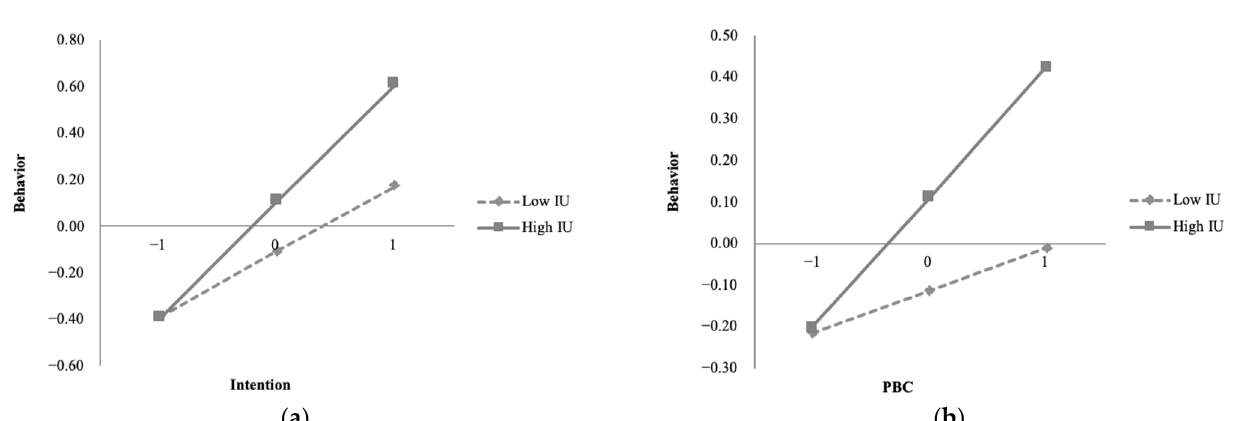
Figure 3. Moderation Analysis ( a ) Moderation effect of Internet use on the relationship between intention and behavior ( b ) Moderation effect of Internet use on the relationship between PBC and